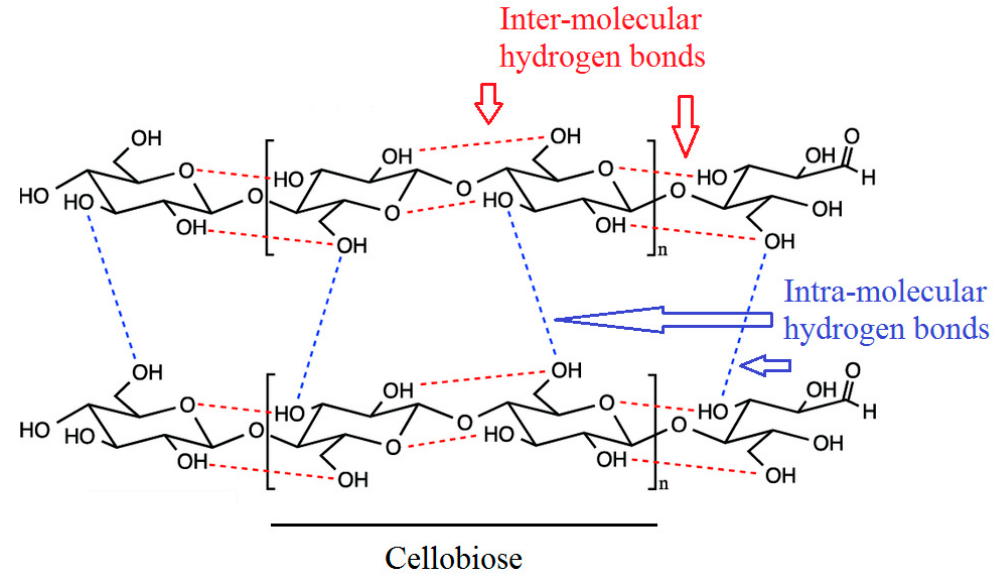
Figure 2. Cellulose structure.